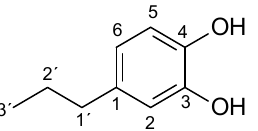
Figure A3. 4- n -propylcatechol ( 3b ). 1 H NMR (399.87 MHz, DMSO- d 6 , 30 °C): 0.855 (3H, t, J = 7.3 Hz, H-3‘), 1.502 (2H, m, H-2 ′ ), 2.363 (2H, m, H-1 ′ ), 6.409 (1H, dd, J = 8.0, 2.1 Hz, H-6), 6.562 (1H, d, J = 2.1 Hz, H-2), 6.627 (1H, d, J = 8.0 Hz, H-5); 3,4-OH not detected. 13 C NMR (100.55 MHz, DMSO- d 6 , 30 °C): 13.55 (C-3 ′ ), 24.24 (C-2 ′ ), 36.66 (C-1 ′ ), 115.33 (C-5), 115.67 (C-2), 118.83 (C-6), 132.91 (C-1), 143.03 (C-4), 144.88 (C-3).